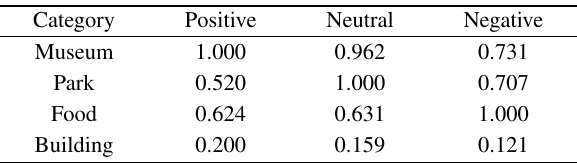
Table 6 Sample of user’s sentiment